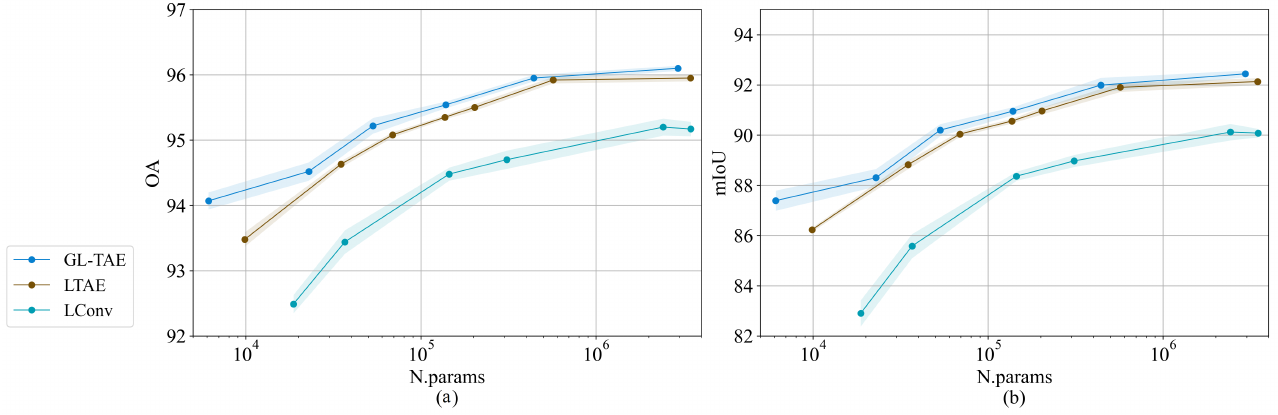
Figure 7. Performance of ( a ) OA and ( b ) mIoU on the TimeSen2Crop of LTAE and LConv; plotted with respect to the parameter